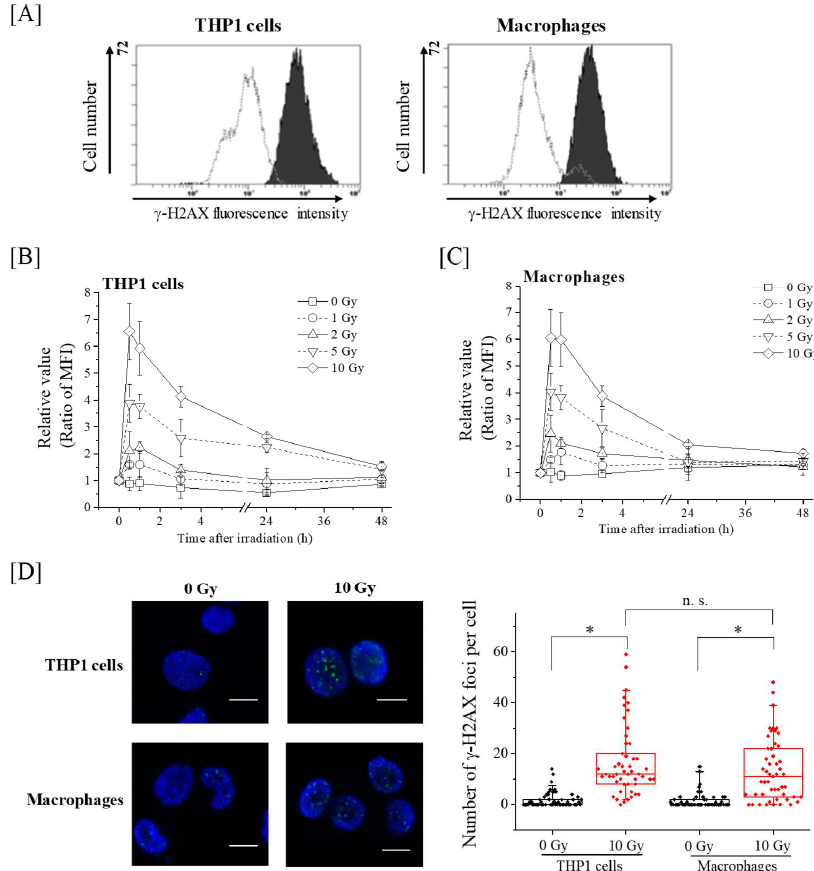
Figure 2. Kinetics of γ -H2AX expression in X-ray irradiated THP-1 cells and macrophages. ( A ) THP-1 cells and macrophages irradiated with 10-Gy X-ray irradiation were harvested 30 min after irradiation and the γ -H2AX expression was analyzed via flow cytometry. Representative histograms of γ -H2AX expression are shown. The dotted line histogram indicates the data from the non-irradiated cells, and the filled black histograms indicate the 10 Gy-irradiated cells. ( B , C ) THP-1 cells ( B ) and macrophages ( C ) were exposed to X-ray irradiation and cultured for 0.5–48 h. After culture, the cells were harvested and the γ -H2AX expression was analyzed via flow cytometry. The relative value of the γ -H2AX mean fluorescence intensity (MFI) from the irradiated cells compared with that of the pre-irradiation cells are shown. Data are presented as the mean ± SD of three independent experiments. ( D ) THP-1 cells and macrophages were exposed to 10-Gy X-ray irradiation and cultured for 24 h. After culture, the cells were harvested and the number of γ -H2AX foci was counted. (Left panel) Representative pictures of γ -H2AX foci are shown. Blue and green fluorescence indicate DAPI (nuclear stain) and γ -H2AX, respectively. The bar in the figure is 10 µ m in length. (Right panel) Box charts of γ -H2AX foci number are shown. Bottoms and tops of the boxes are the 25th and 75th percentiles, respectively. The lines across the boxes are the median values. The ends of the whiskers represent 5th and 95th percentiles. The filled diamonds mean data of each cell. * and n.s. mean p < 0.01 and p > 0.05,